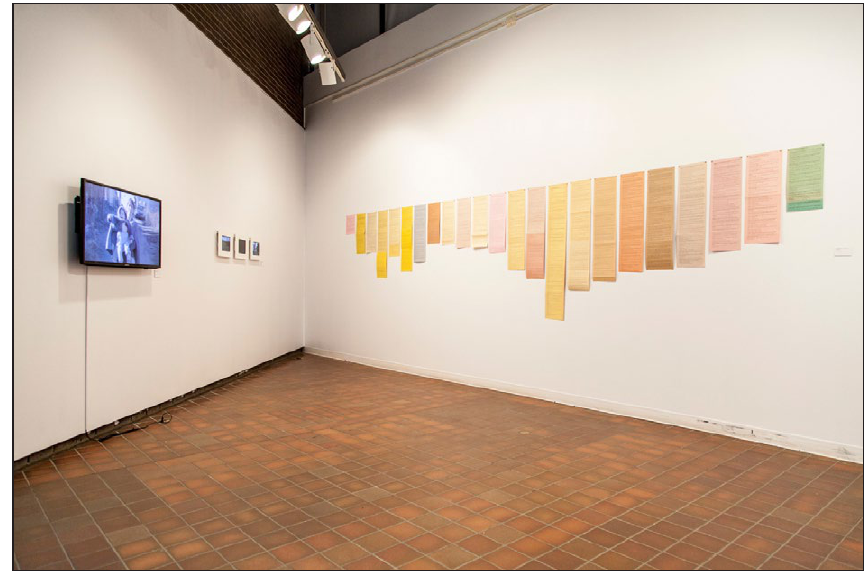
Figure 4: Lenka Clayton. Artist-in-Residence-in-Motherhood 2012–2015. Photo courtesy of Michael